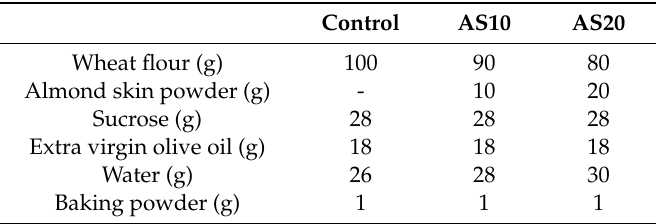
Table 1. Formulation of the experimental biscuits (per 100 g of flour). Control = Biscuits without Almond Skins; AS10 and AS20 = Biscuits prepared by adding 10 g and 20 g Almond Skin Powder per 100 g of Wheat Flour, respectively. Control AS10 AS20 Wheat flour (g) 100 90 80 Almond skin powder (g) - 10 20 Sucrose (g) 28 28 28 Extra virgin olive oil (g) 18 18 18 Water (g) 26 28 30 Baking powder (g) 1 1